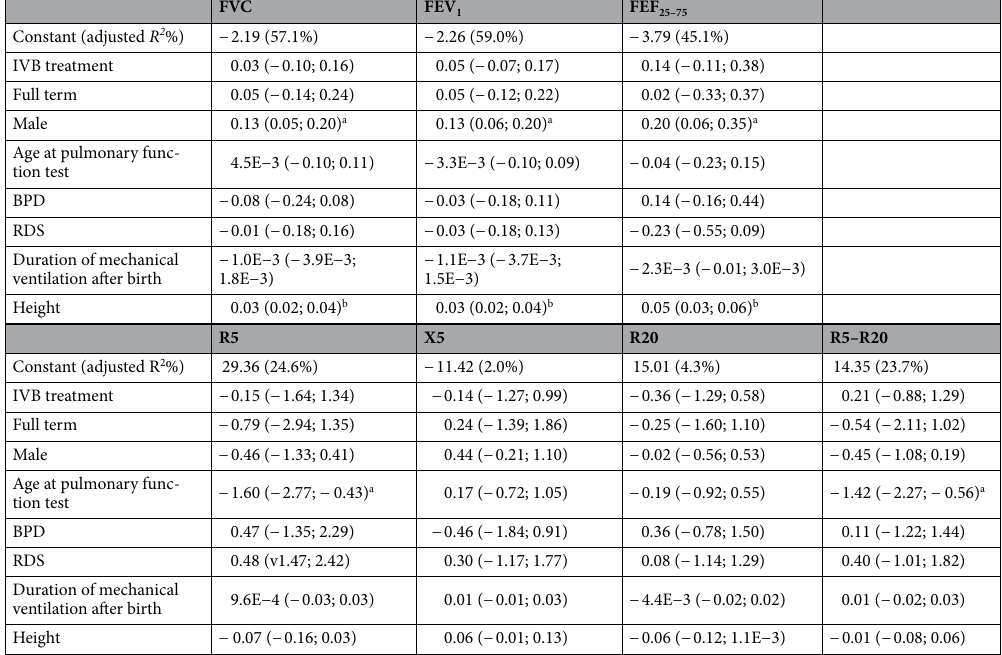
Table 3. Multivariate linear regression model of risk factors for pulmonary function parameters. BPD bronchopulmonary dysplasia;